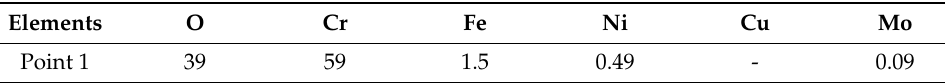
Figure 1. Scanning electron microscopy (SEM) image and corresponding energy-dispersive X-ray spectroscopy (EDS) maps of an inclusion. Table 2. Relative compositions (at.%) at point 1 in Figure 1.